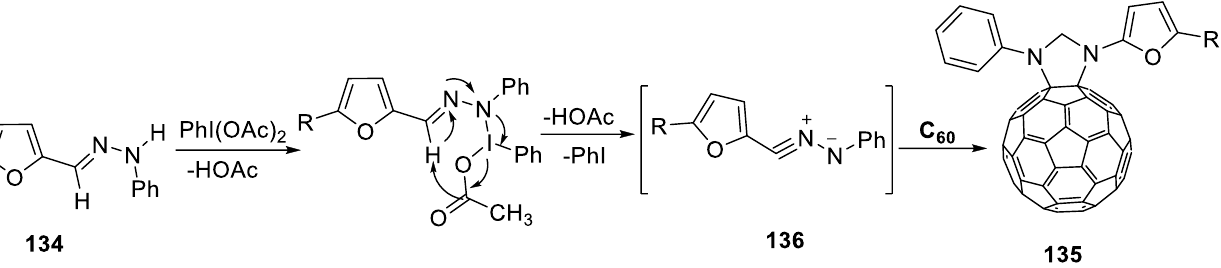
Figure 19. Possible mechanism for the formation of furylpyrazolino[60]fullerene derivatives.